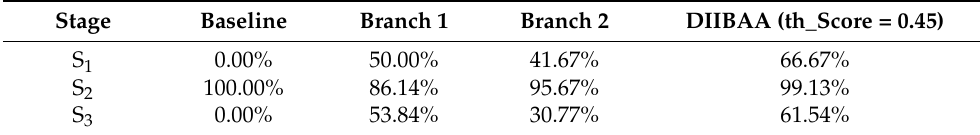
Table 5. Results on female.